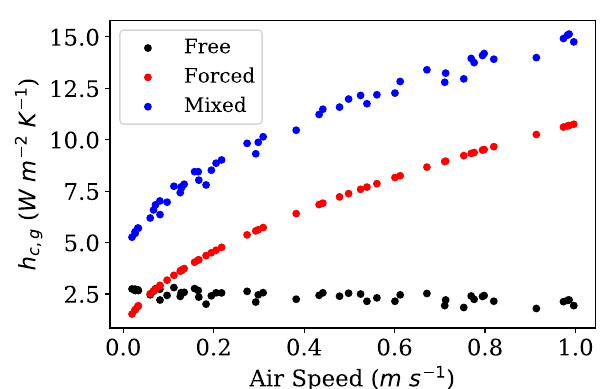
Figure 8. Comparison in mixed, free, and forced convection heat transfer coefficients for standard globe over all 45 experiments. Force convection is only dependent on velocity so it creates a smooth curve. The free and t g , which generates the variation. The mixed model combines effects mixed models include dependency on t a − of both and converges to the free model at v a goes to zero and approaches the forced model as it